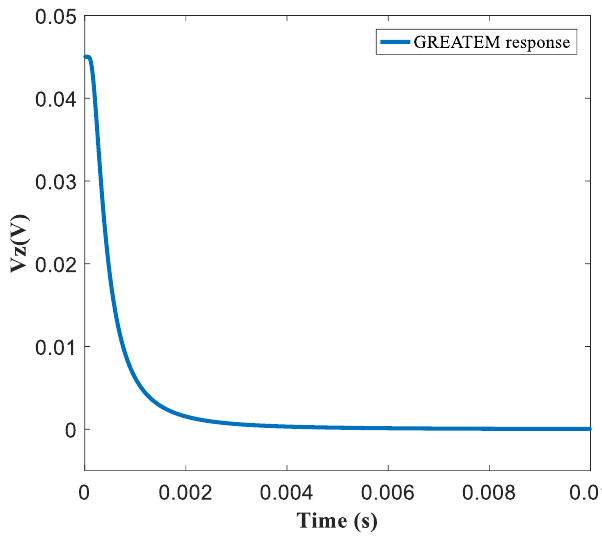
Figure 1. The calculated GREATEM response of uniform